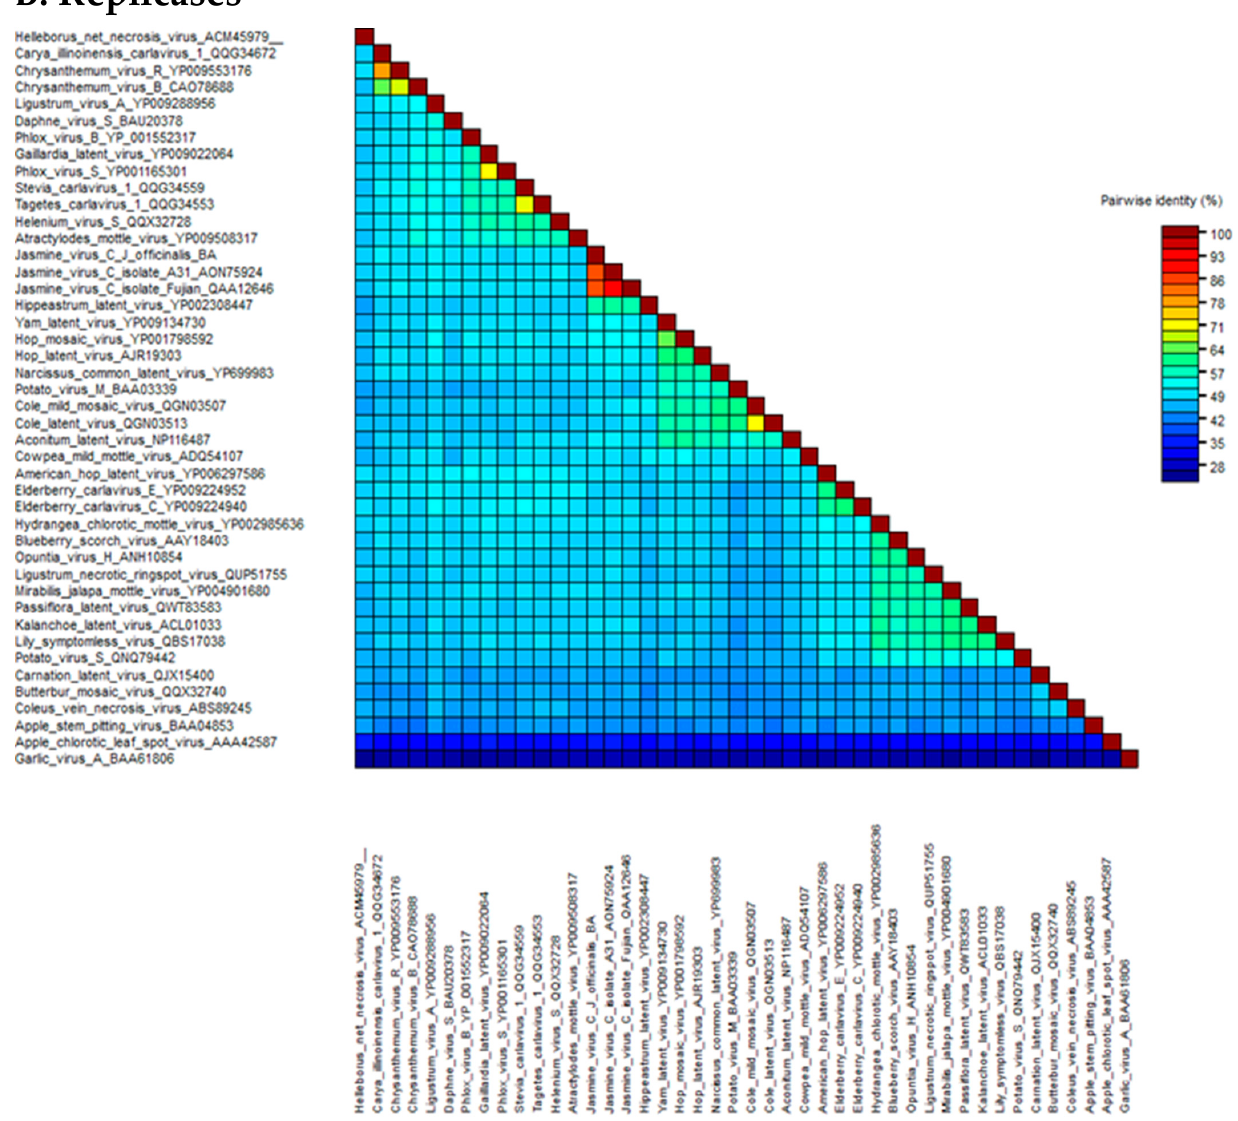
Figure 2. Heat map graphics of pairwise identity matrix analysis for coat proteins ( A ) and ORF1 polyprotein ( B ) of the JaVC isolates compared to other carlaviruses and outgroup flexivirids homolog proteins. GenBank accession numbers are by the virus name (refer also to Supplementary Materials Table S2).